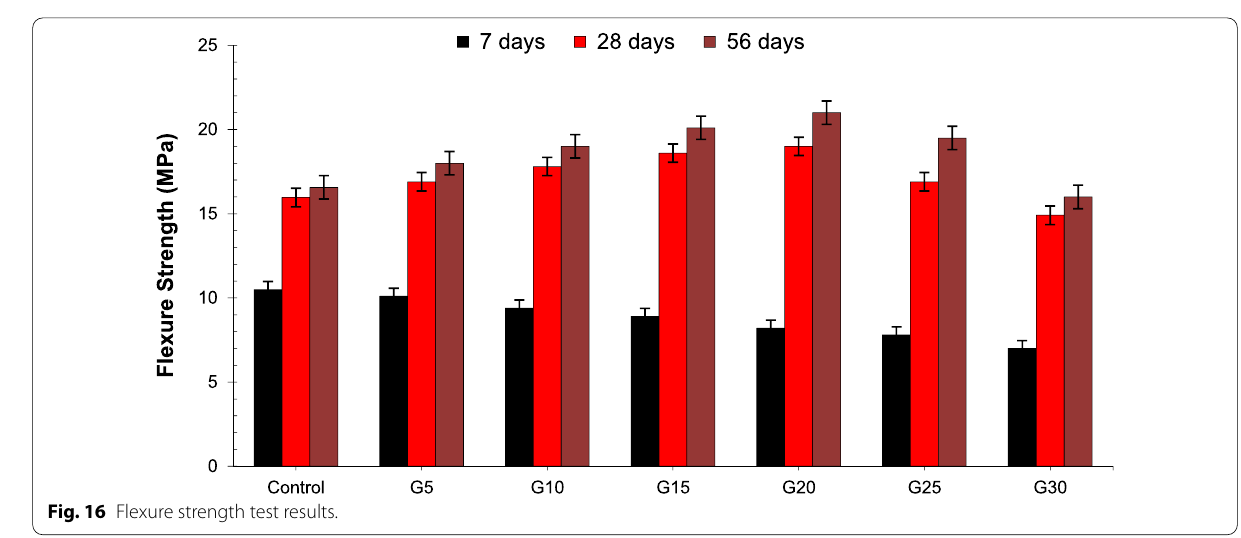
Fig. 16 Flexure strength test results.